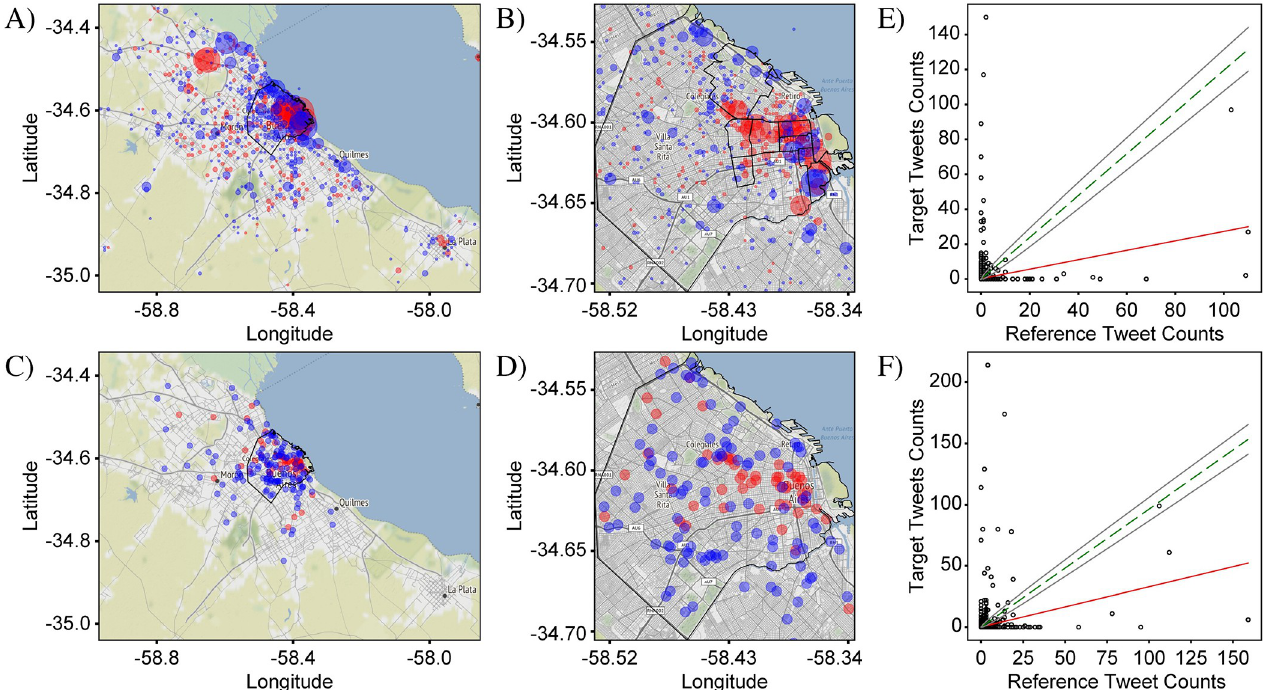
Fig 7. Analysis of “tango” vs. “fu´tbol”. (A) Differential distribution of words “tango” and “fu´tbol” in CABA+. Blue (red) circles show where “fu´tbol” (“tango”) is more prominently tweeted. The use of “tango” is most strongly concentrated in the city, marked by the black outline, and is weak but fairly uniform in the surrounding provinces. For “fu´tbol”, on the other hand, the contrast between the city and the outskirts is not as severe, and the distribution in the outskirts shows a distinct concentration near the major roadways. (B) Same as (A), but recalculated for CABA. Over this extent, it is clear that the use of “tango” is mostly confined to a region within the upper-right quadrant of the graph which corresponds to the downtown area of Buenos Aires. The outlines of the neighborhoods of La Boca, San Telmo, Palermo, Monserrat, Balvanera, San Nicola´s, Almagro and Boedo, known for having many important Tango clubs, are marked in black in the graph, and coincide well with the distribution of red circles. (C) A plot over the extent of CABA+ of soccer-related locations (i.e., soccer fields and stadiums), marked by blue circles, and tango-related locations (i.e., tango schools and tango dance and performance venues), marked by red circles. The locations and their GPS coordinates were identified using Google maps. (D) Same as (C), but zoomed in to the extent of CABA. The agreement between the distributions of “tango” and “fu´tbol” tweets and the distributions of tango- and soccer-related locations is very good, indicating a strong connection between the two for both extents. (E) and (F) Frequency comparison plots for the data in (A) and (B), respectively. Both show a high degree of anticorrelation indicating a strong driver of variation. CABA+ Statistics: N T = 2,288, N R = 2,327, S PCC = 0.76, KSS = 0.20, GMI = 0.19. CABA Statistics: N T = 1,716, N R =